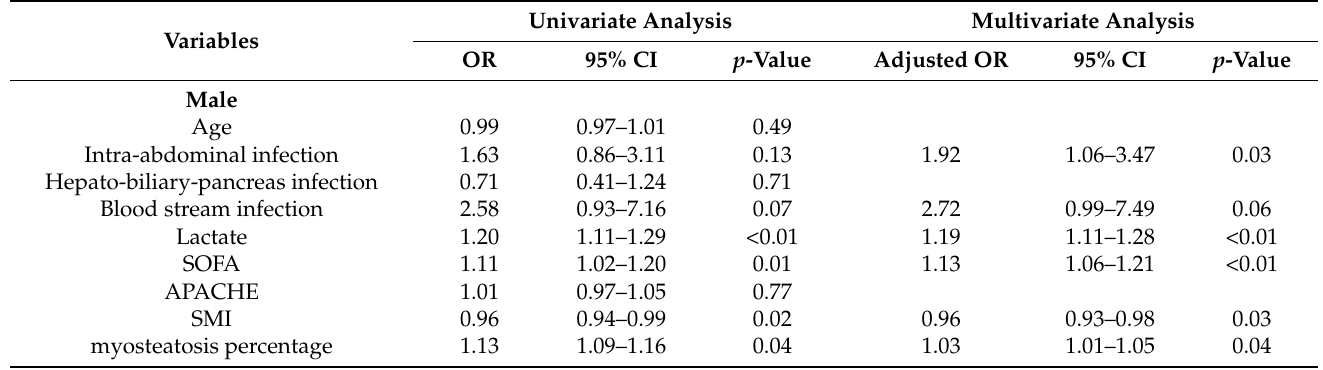
Table 3. Multivariate analysis of septic shock patients for its association with 28-day